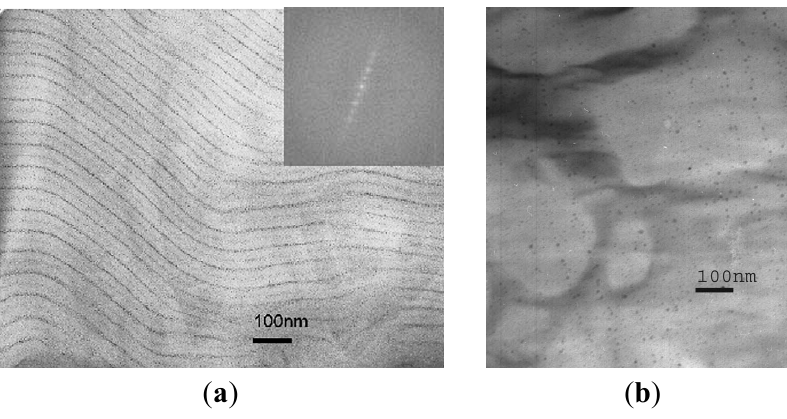
Figure 10. Electron micrographs for poly(norbornene methanol) / poly(norbornene dicarboxylic acid) (PNORMEOH/PNORCOOH) diblock copolymer: ( a ) stained with I vapor; and ( b ) doped with iron oxide by submerging a thin film in FeCl Reprinted with permission from [32]. Copyright 2006 Elsevier